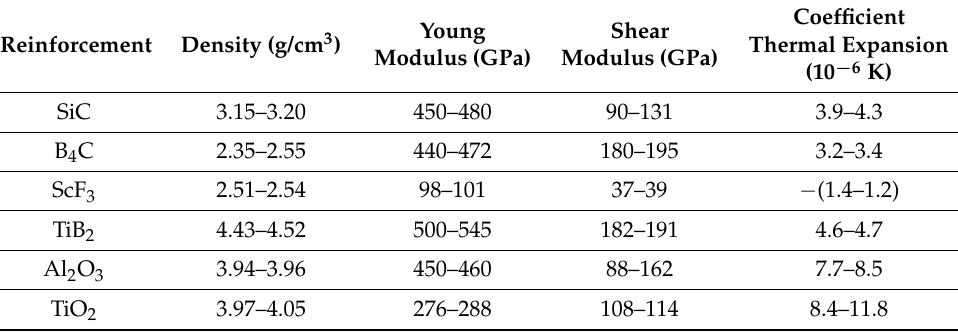
Table 3. Characteristics of reinforcement particles.